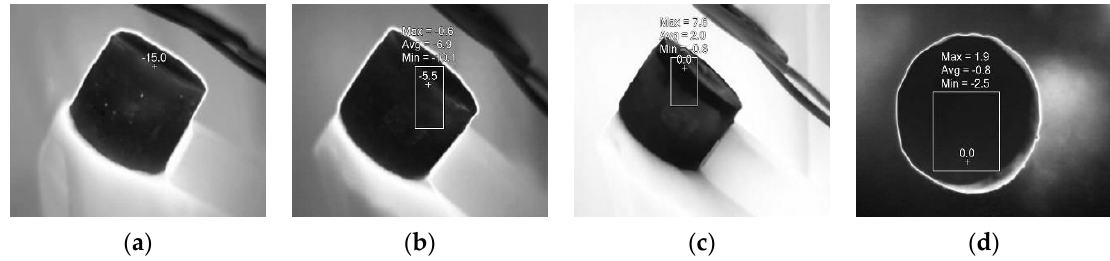
Figure 11. ( a ) Ambient temperature of ice layer surface; ( b ) Temperature of heating for 30 s; ( c ) Temperature of heating for 54 s; ( d ) 0 °C on the surface of specimen.